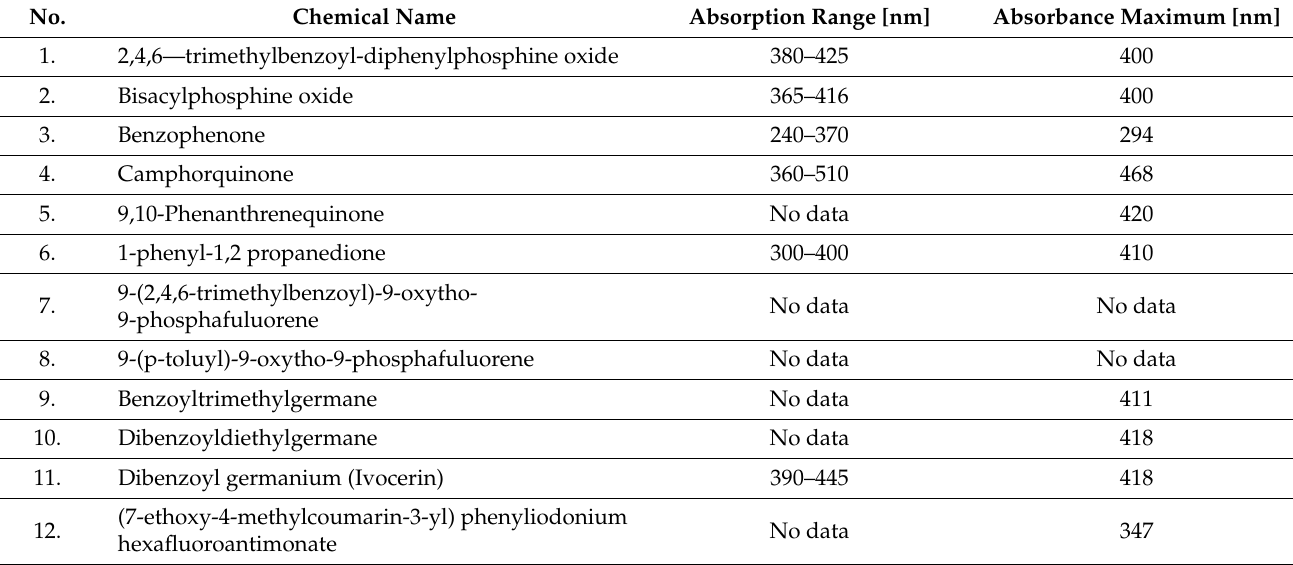
Table 2. Chemical names, absorption range [nm] and maximum of absorption [nm] of photoinitiators used in review.